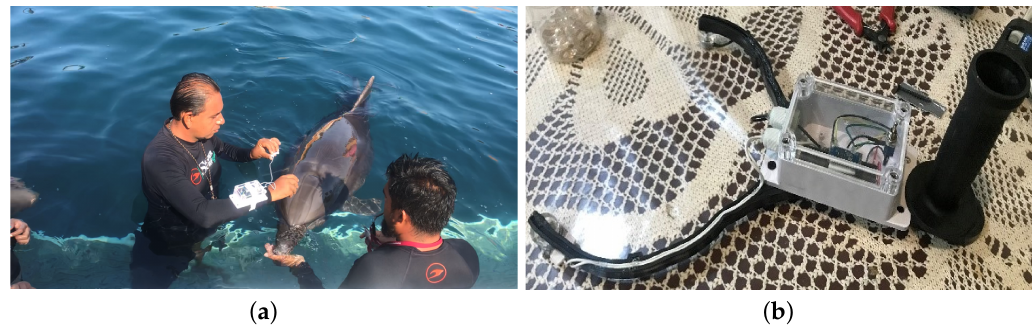
Figure 12. EEG s sensor design. ( a ) Searching for connection points and ( b ) Designing of an ergonomic handle.